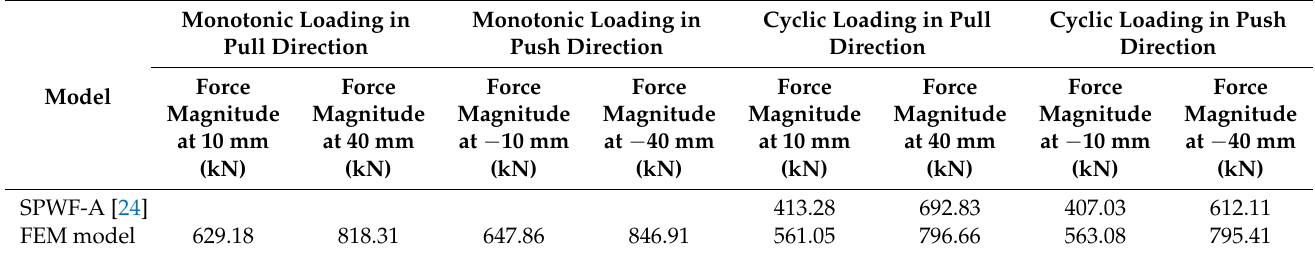
Table 4. Some data from cyclic loading of FEM model and literature test.